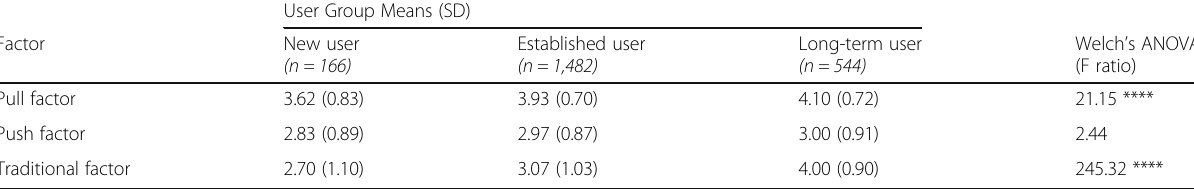
Table 4 Results of Welch ’ s ANOVA for the factors ’ mean values